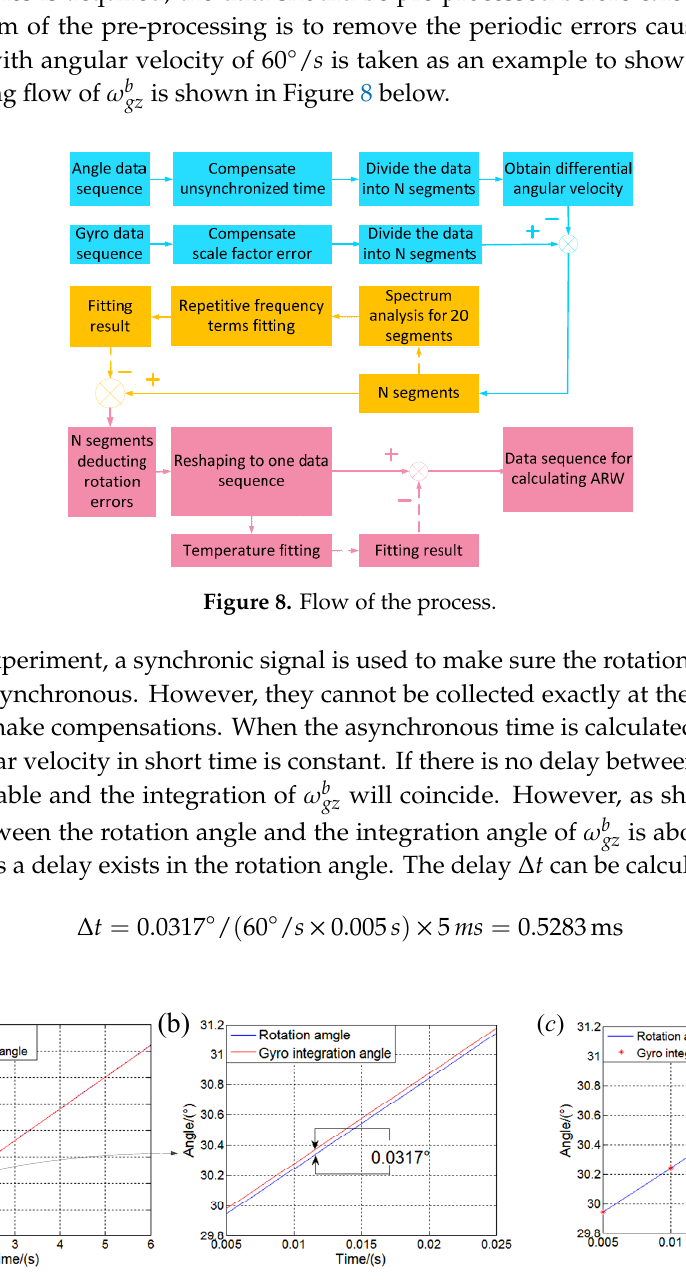
Figure 10. Spectrum analysis. Form